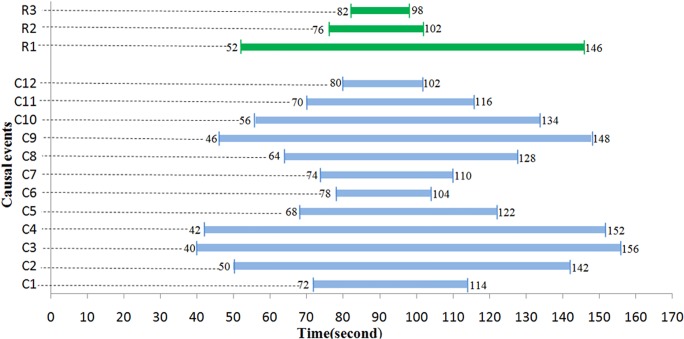
Temporal information acquired in experiment.